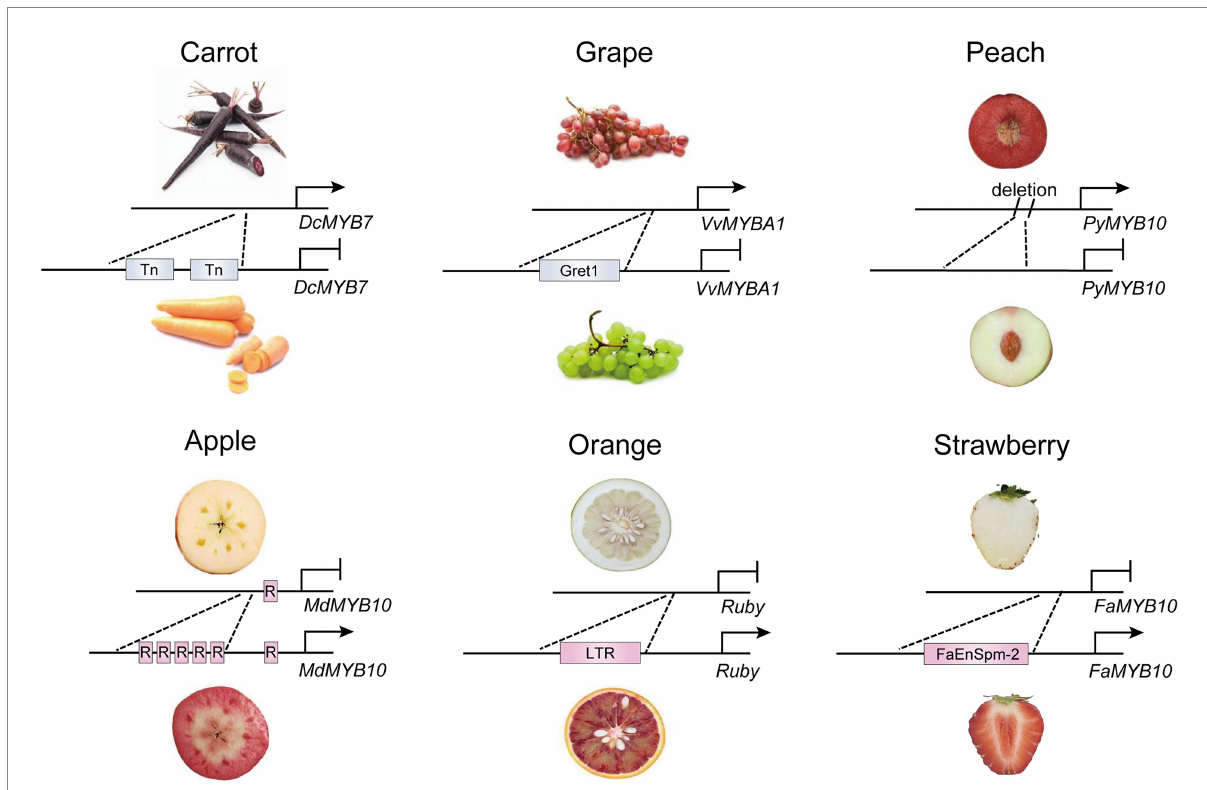
FIGURE 1 Transcriptional regulation of R2R3-MYB activators by natural variations in promoters. The natural variations in promoters of DcMYB7 and FaMYB10 in carrot (Xu et al., 2019) and strawberry (Castillejo et al., 2020) caused by insertion of transposons. In orange (Butelli et al., 2012) and grape (Kobayashi et al., 2004), insertion of retrotransposon leads to variations in promoter of Ruby and VvMYBA1 . The short tandem repeats insertion and fragment deletion have also been found in promoter of MdMYB10 in apple (Espley et al., 2009) and PyMYB10 in peach (Guo et al., 2020), respectively. Tn, transposon; Gret1, grapevine retrotransposons 1; R, short tandem repeats; LTR, long terminal repeats; FaEnspm-2, CACTA-like transposon FaEnspm-2; → , activation; —|,